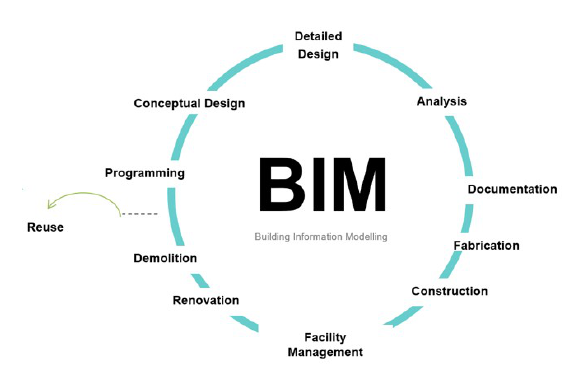
Figure 2. BIM – Full Life Cycle